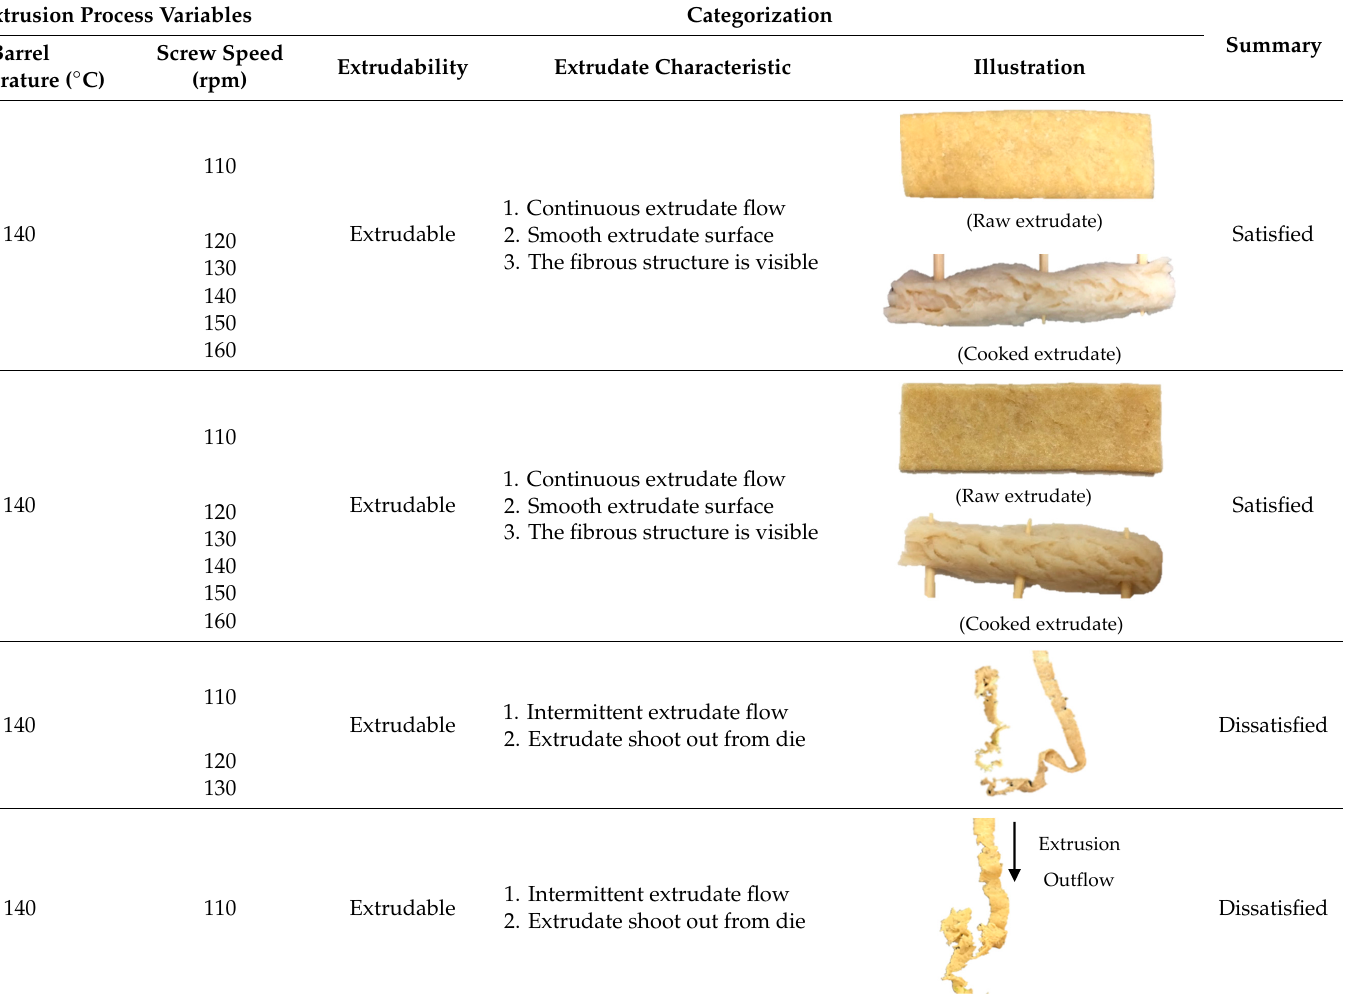
Table 3. Physical and textural properties of the